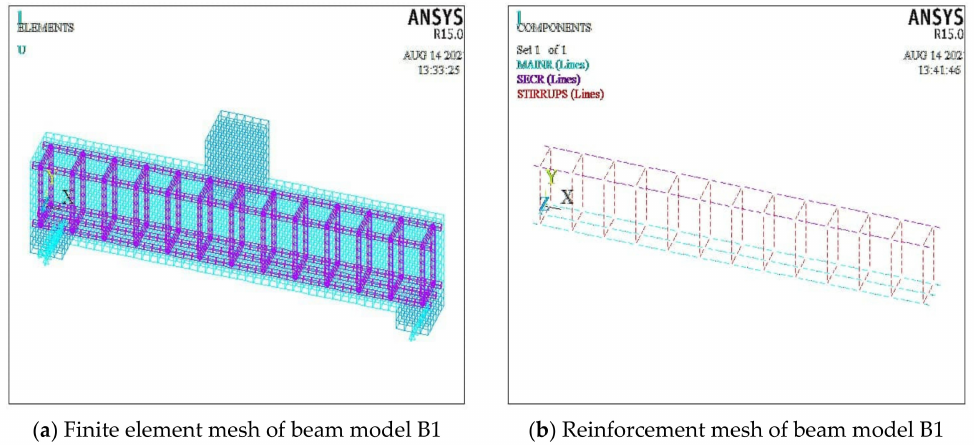
Figure 3. 3D views of element mesh and reinforcements of beam model